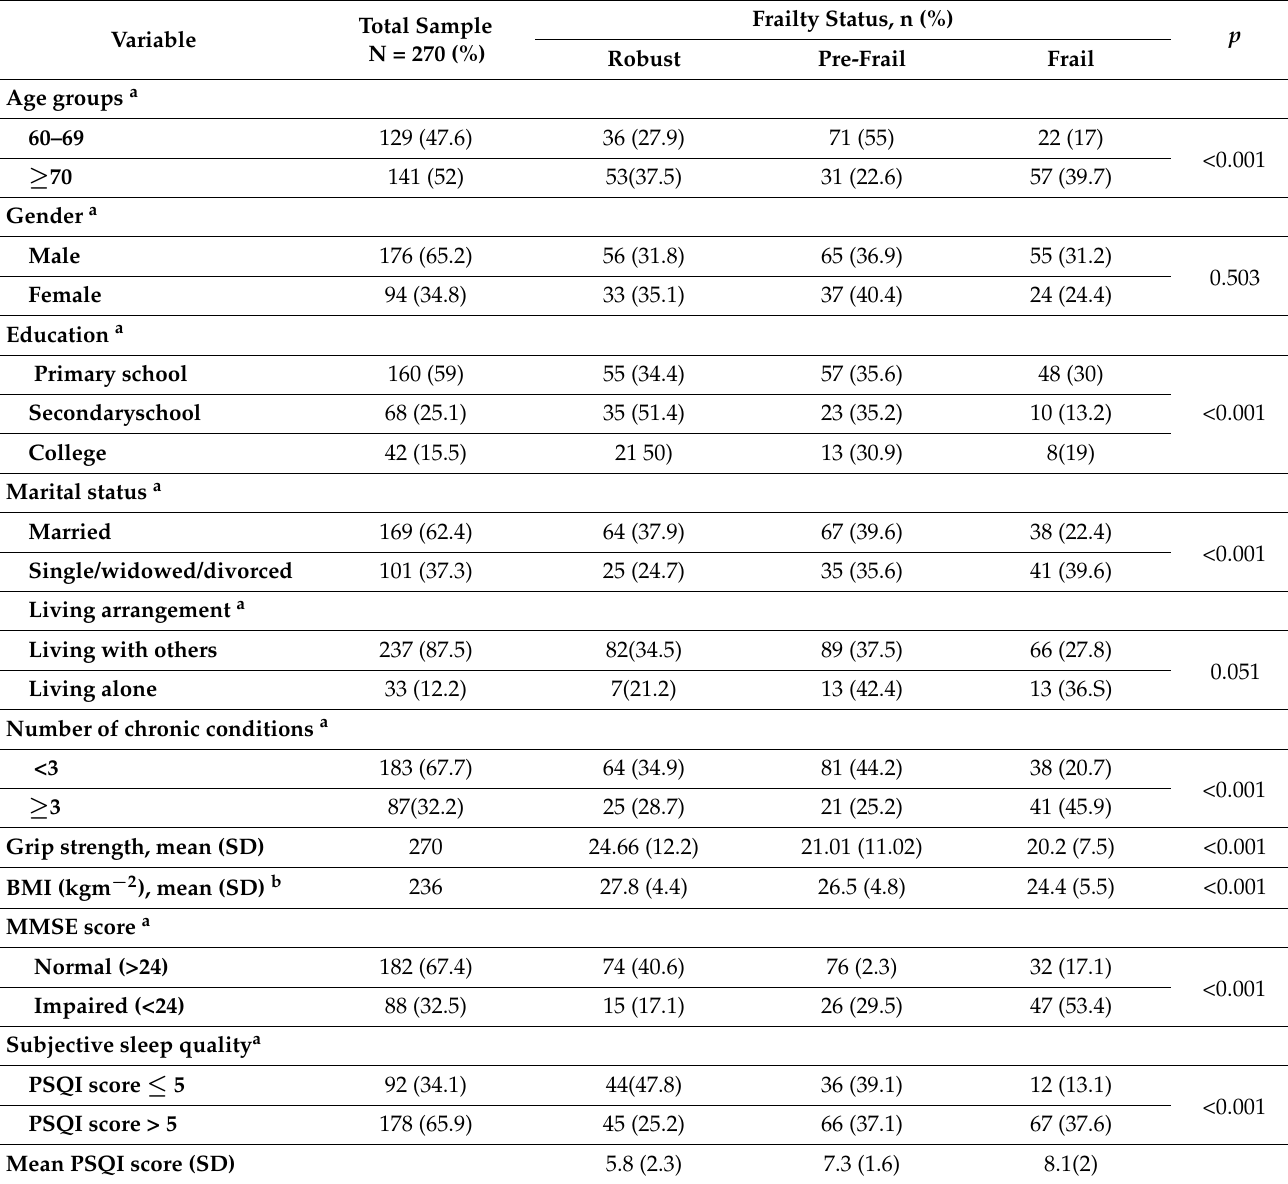
Table 1. Sociodemographic and clinical characteristics of the study sample according to frailty